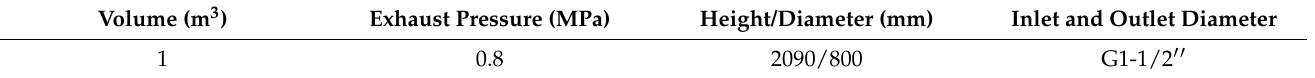
Table 2. Accumulator parameters.